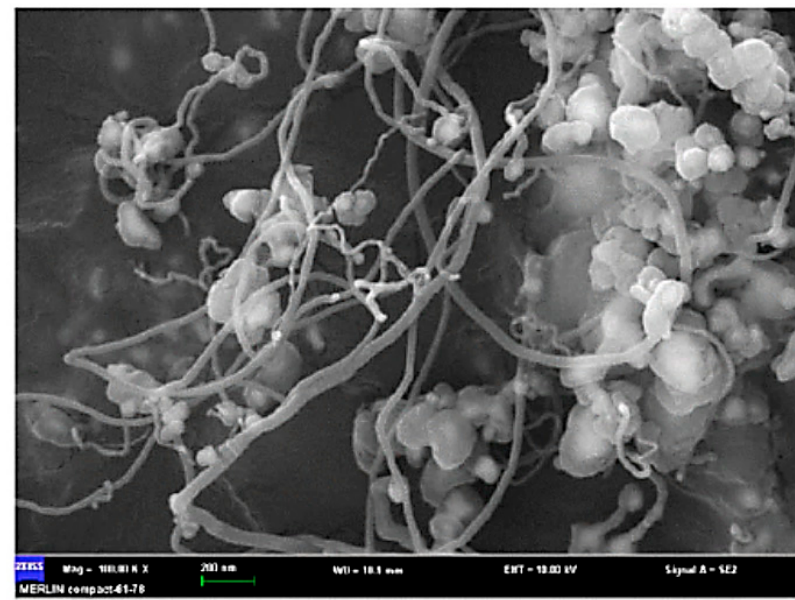
Figure 4. CNT growth on Ni-based catalyst (adapted from [74]).